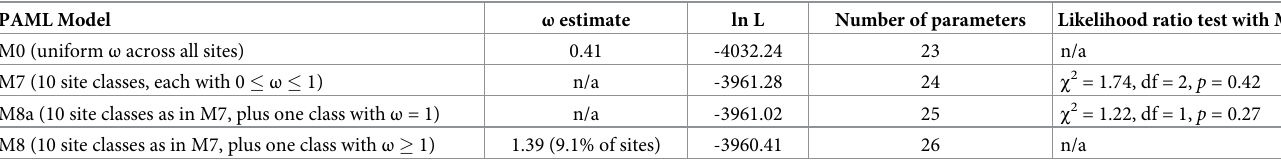
Table 1. PAML sites tests for positive selection acting on atlas in the melanogaster